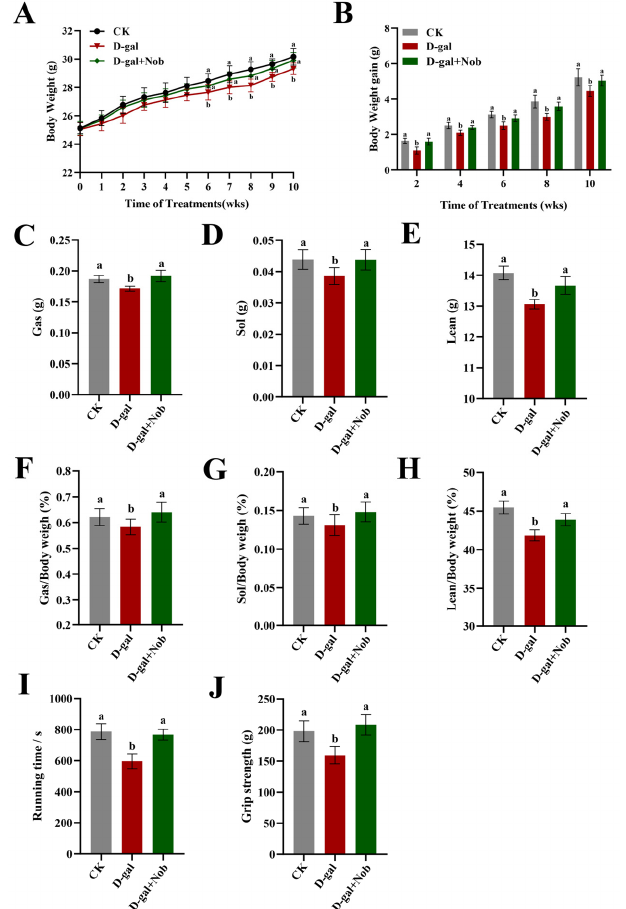
Figure 1. Nob increased skeletal muscle mass in D-gal-induced aging mice. ( A , B ) Body weight (BW) ( A ) and BW gain ( B ) in the CK, D-gal, and D-gal + Nob groups, n = 10. ( C , D ) The weight of gastrocnemius (Gas) and Gas to BW in the CK, D-gal, and D-gal + Nob groups, n = 10. ( E , F ) The weight of soleus (Sol) and Sol to BW in the CK, D-gal, and D-gal + Nob groups, n = 10. ( G , H ) The weight of lean and lean to BW in the CK, D-gal, and D-gal + Nob groups, n = 8. ( I , J ) Running time and grip strength in the CK, D-gal, and D-gal + Nob groups, n = 6. Signi fi cant di ff erences between treatment groups are represented by the lowercase le tt ers a and b ( p < 0.05).